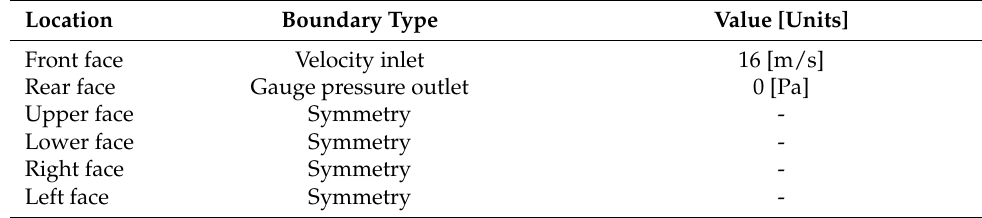
Table 6. Boundary conditions.